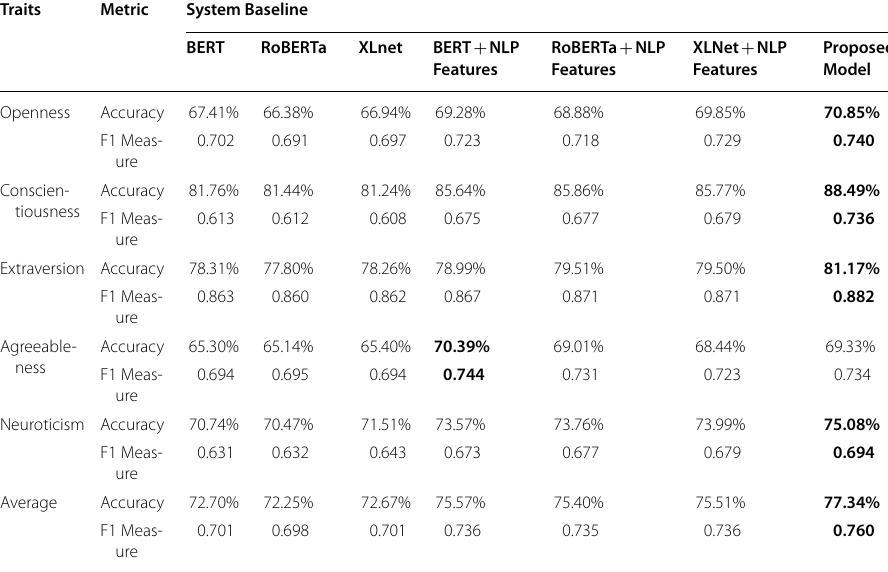
Table 8 Personality prediction result using Twitter dataset Traits